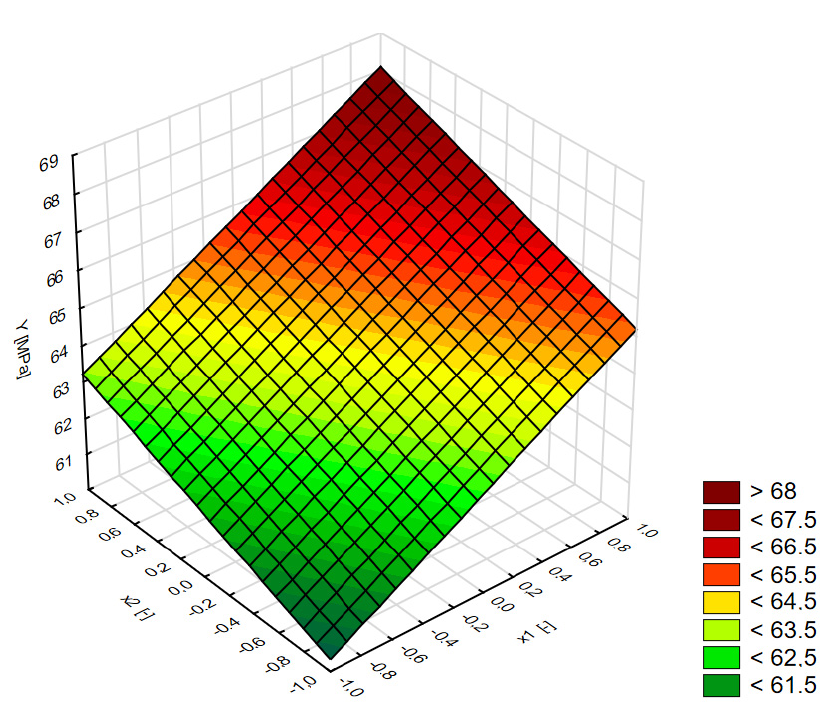
Figure 7. The changes in compressive strength (Y) of concrete depending on the amount of RCM ( x 1 ) and the amount of FAS – RCM ( x 2 ).